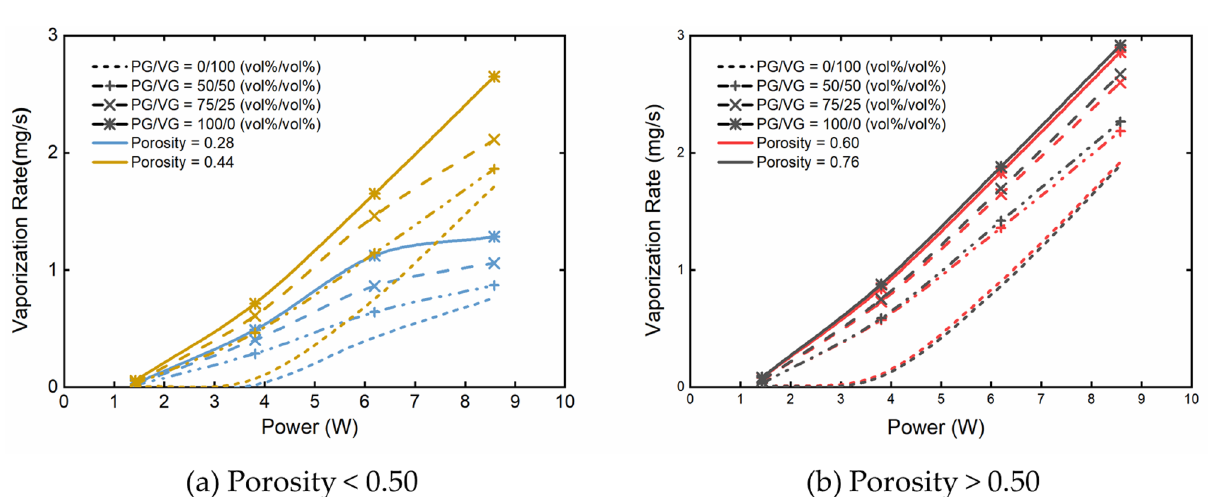
Figure 3. Model predictions of liquid vaporization rate based on the input power for different liquids (PG/ VG = 0/100, 50/50, 75/25, 100/0 vol%/vol%) at ( a ) porosity < 0.50 (0.28, 0.44) and ( b ) porosity > 0.50 (0.60, 0.76) with 3 s puff duration, 30 s puff interval and 55 mL puff